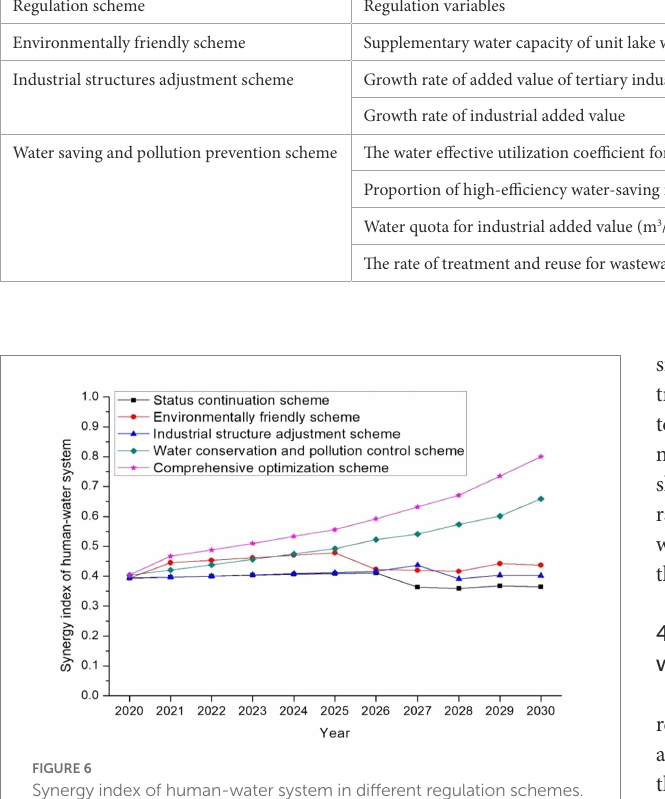
TABLE 5 Main control parameters of different schemes. Regulation